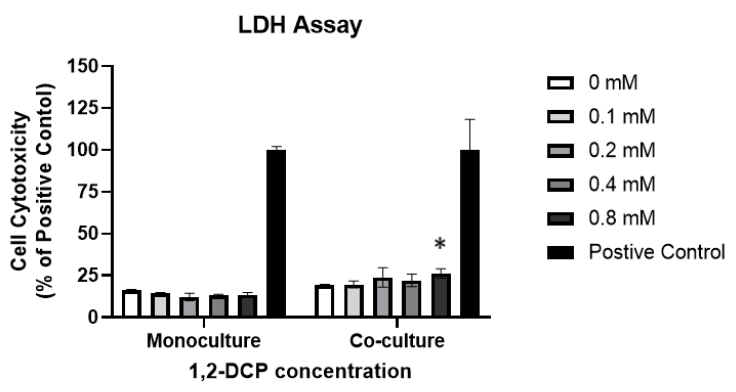
Figure 3. Cytotoxic effects of 1,2-DCP on monocultured MMNK-1 cholangiocytes and MMNK-1